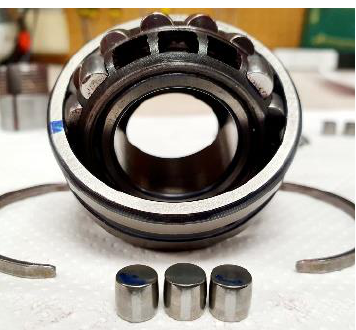
Figure 11. Sensors 2020 , 20 , x FOR PEER REVIEW